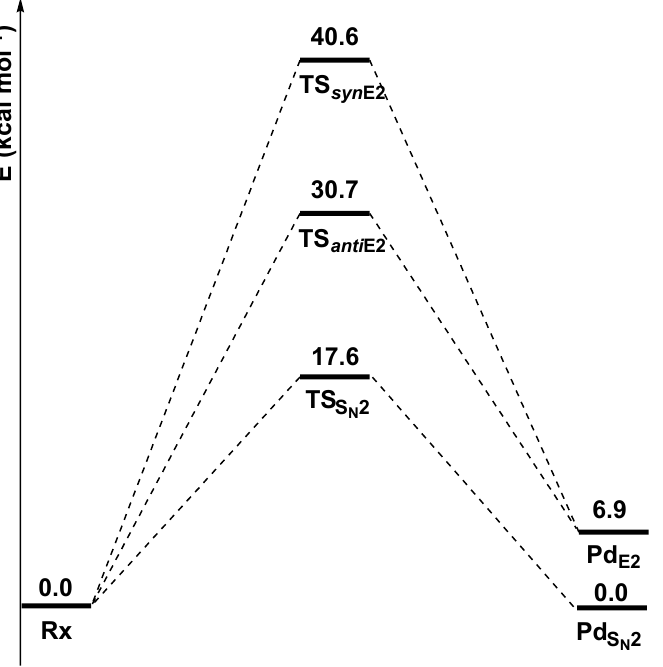
Figure 1. Gas-phase reaction profiles (kcal mol − 1 ) of the S N 2, anti -E 2 , and syn -E2 mechanisms computed at the M06-2X/6-311++G(2df,2p) level of theory.